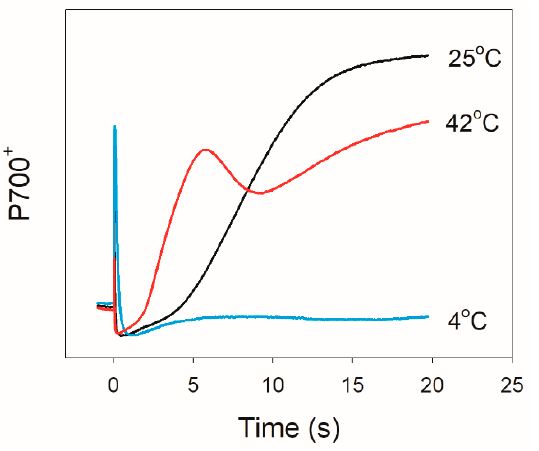
Figure 1. Changes in P700 redox kinetics after transition from dark to actinic light (1455 μ mol pho- m − 2 s − 1 ) at 25 ◦ C, 4 ◦ C, and 42 ◦ C. Data are mean values of five leaves from five individual tons m − 2 s − 1 ) at 25 °C, 4 °C, and 42 °C. Data are mean values of five leaves from five individual plants.